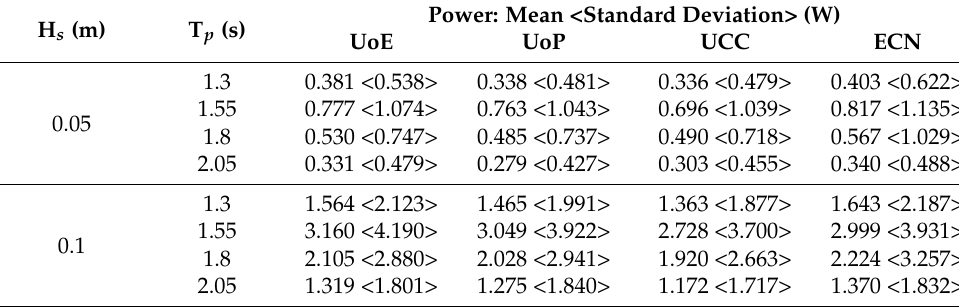
Table 5. Mean power and standard deviation of inferred power across